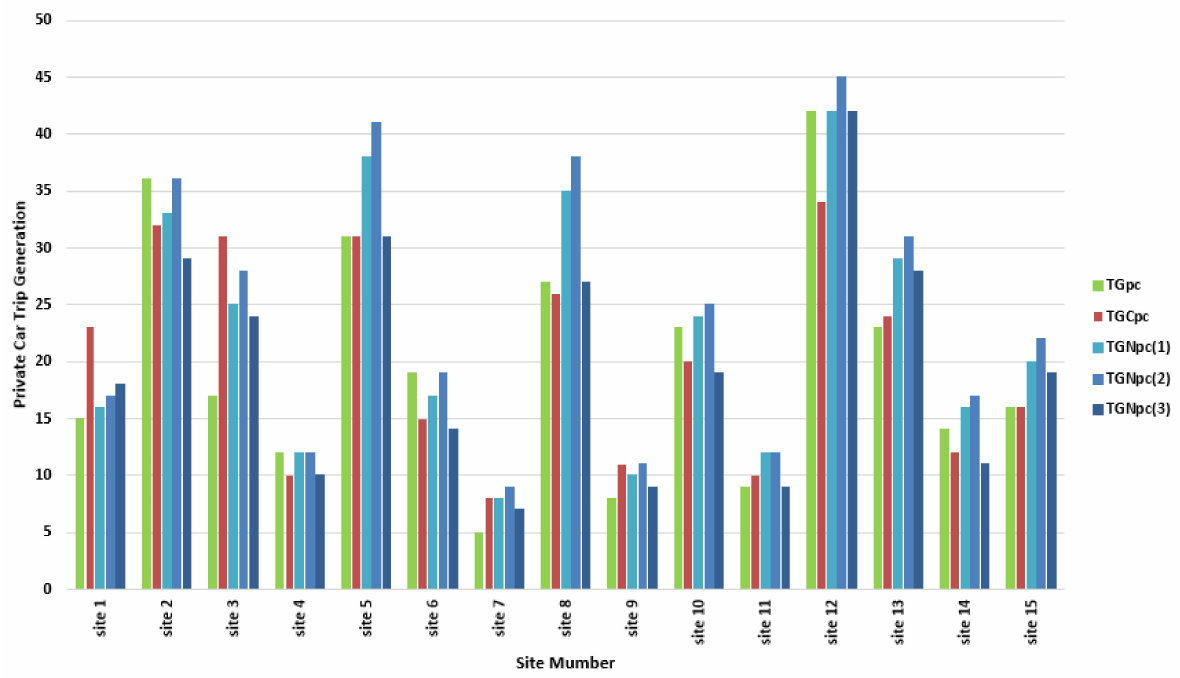
Figure 2. Comparison of private car trip generation estimations at the